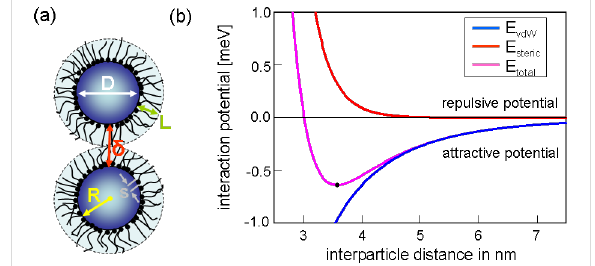
Figure 9: (a) Scheme of two particles with a metallic core of radius R surrounded by a ligand shell of the thickness L , s denotes the required distance of two neighboring ligand head groups on the surface of the particle cores and δ the surface distance between the metallic cores. (b) Total interaction potential calculated from the contributions of the steric repulsion (red) and the attractive van der Waals potential (blue) for two Co nanoparticles of a diameter of 3.3 nm stabilized with oleic acid ( L = 1.17 nm, s = 0.51 nm).